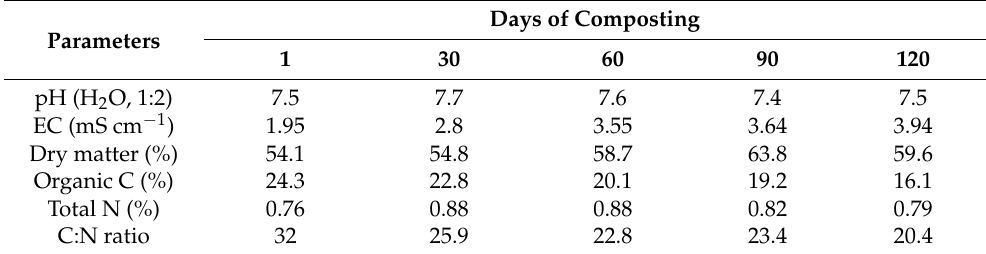
Table 3. Changes in compost parameters during heap